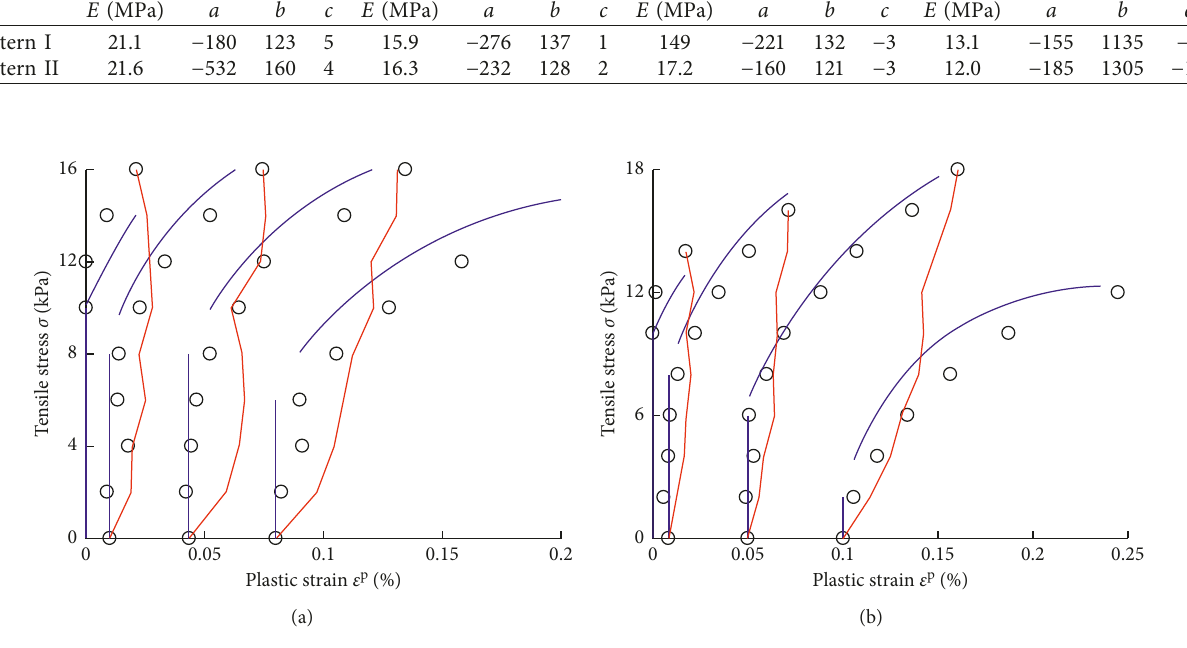
Figure 17: The comparisons of measured data and fitted functions by proposed model for (a) loading pattern I and (b) loading pattern